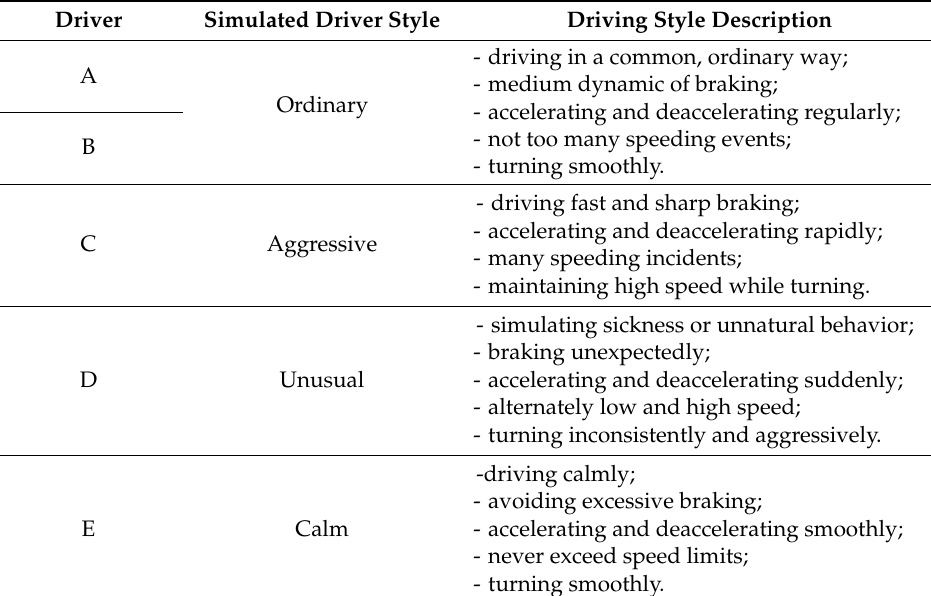
Table 2. Test rides and their descriptions